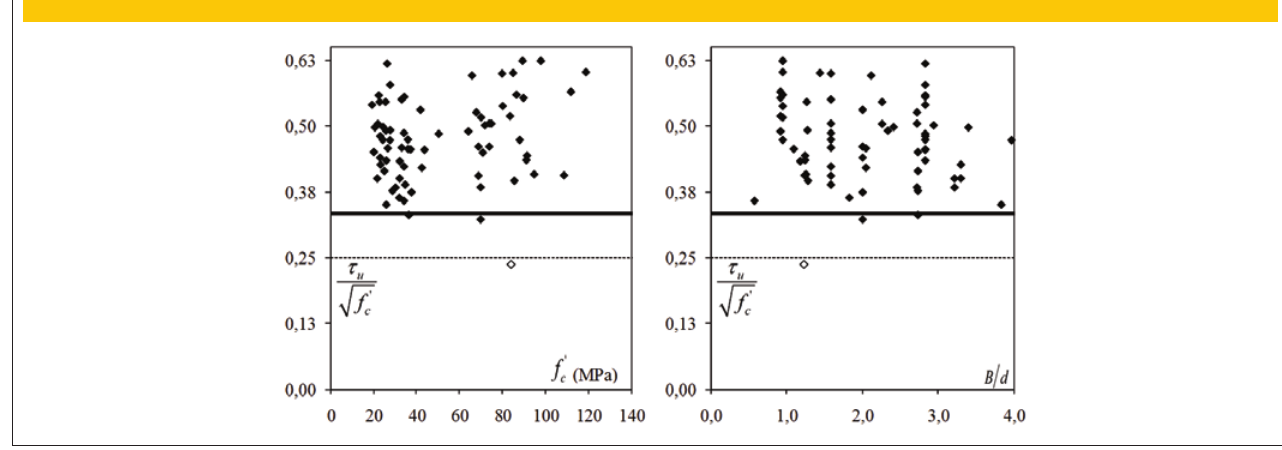
Figure 11 � Com�arison of results from database with those using recommendations of ACI 318 [7]